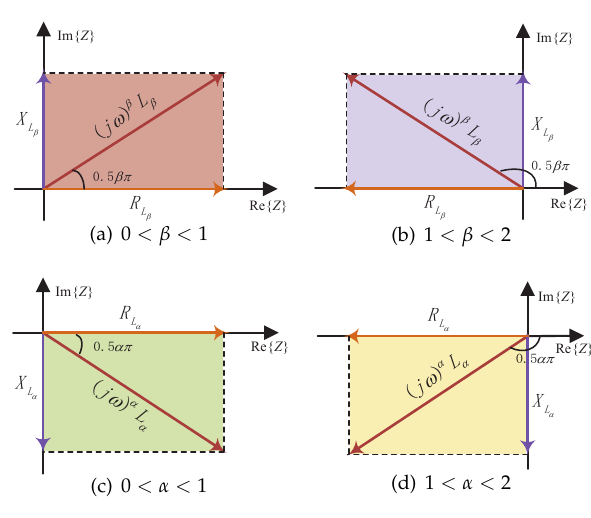
Figure 3. Phasor diagram.